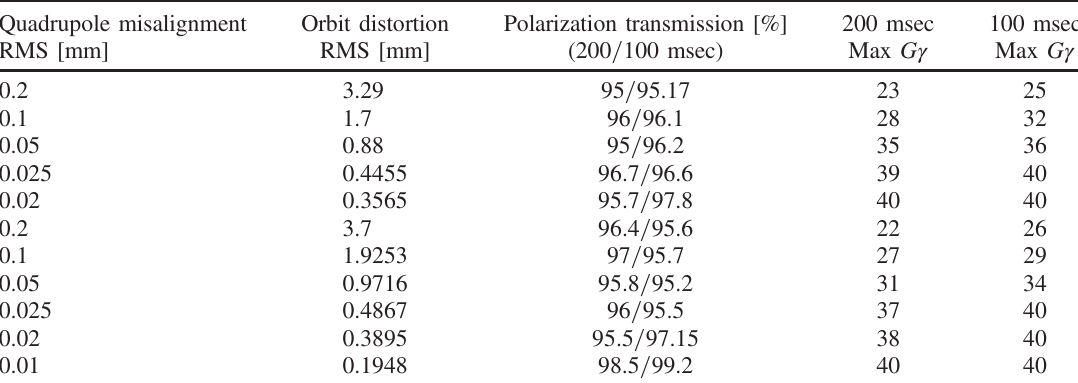
TABLE I. Table of quadrupole misalignment orbit RMS and polarization for two different random seeds assuming no orbit correction scheme applied. Shown are results from two ramp times 200 and 100 msec. Quadrupole